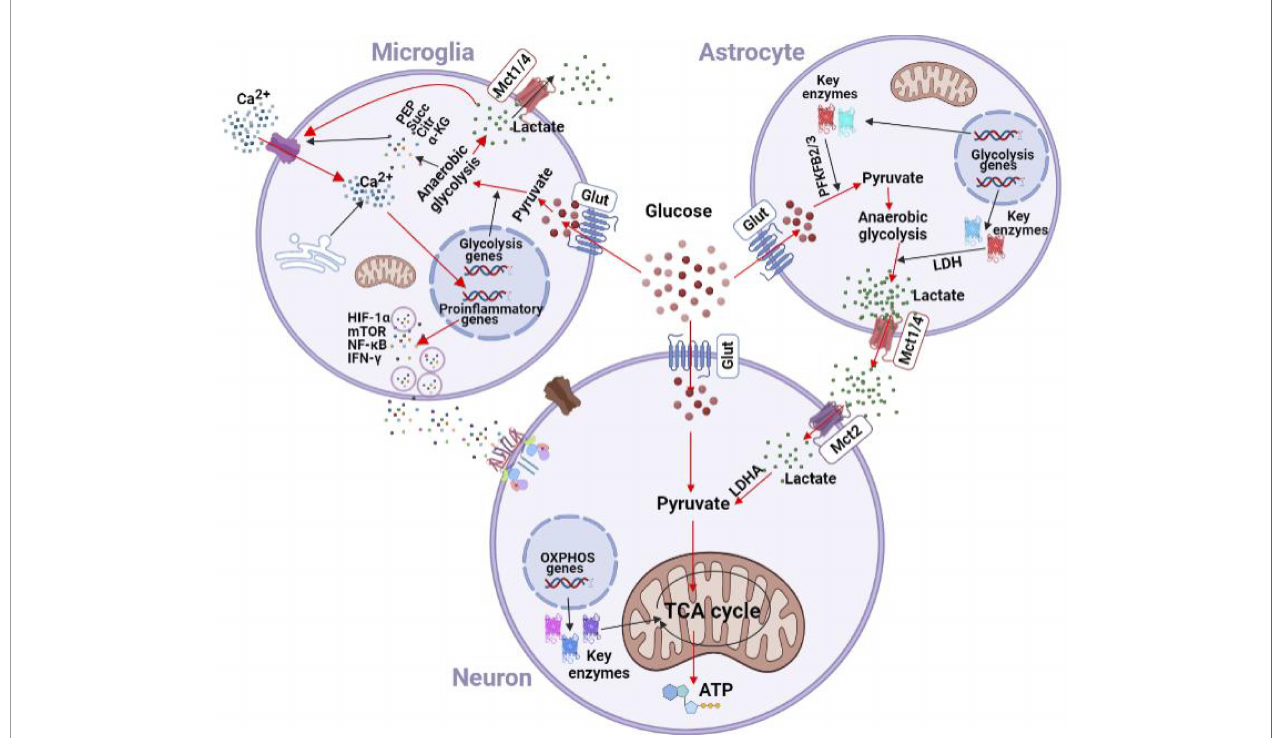
FIGURE 2 | Effects of chronic nerve injury on glycometabolism in microglia and astrocytes. Glycolysis is enhanced in microglia under hypoxic and in fl ammatory insults. Enhanced glycolysis leads to accumulation of lactate, PEP, succinate, citric acid, and a -KG. Lactate is transferred into synpatic microenvironment by the lactate shuttle to facilitate the Ca 2+ channel in cytomembrane and inhibit the Ca 2+ channel in the endoplasmic reticulum. The resulting increase of Ca 2+ concentration in cytoplasm activates in fl ammatory pathways (e.g., NF- k B, HIF-1 a , mTOR, and IFN- g ) to promote the transcription of pro-in fl ammatory factors in microglia. Astrocytes express high levels of PFKFB 2/3 , and could metabolize glucose into pyruvate. Upon chronic nerve injury, glutamate is taken up by astrocytes in a Na + -dependent mechanism, which in turn increases intracellular Na + concentration and activates Na + -K + -ATPase on the cell membrane to promote glucose uptake and induce anaerobic glycolysis. Lactate is then transferred out of astrocytes via Mct1/4, and enters neurons via Mct2. Glut, glucose transporter; Mct, monocarboxylate transporter; PEP, phosphoenolpyruvic acid; Succ, succinate; Citr, citric acid; a -KG, a -ketoglutarate; HIF-1 a , hypoxia inducible factor-1 a ; mTOR, mammalian target of rapamycin; IFN- g , interferon- g ; PFKFB, 2, 6- phosphofructo-2-kinase; LDH, lactate dehydrogenase; LDHA, lactate dehydrogenase A; TCA, tricarboxylic acid; OXPHOS, oxidative